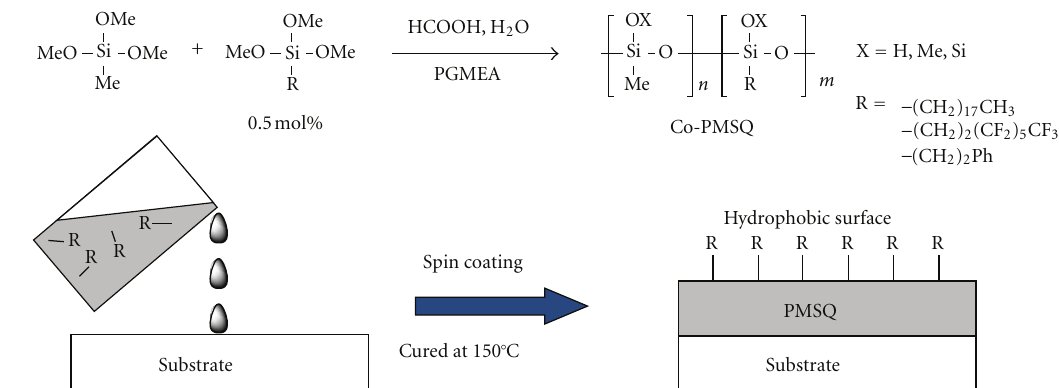
Figure 11: Synthesis of co-PMSQ and fabrication of the hydrophobic gate-insulating layers.